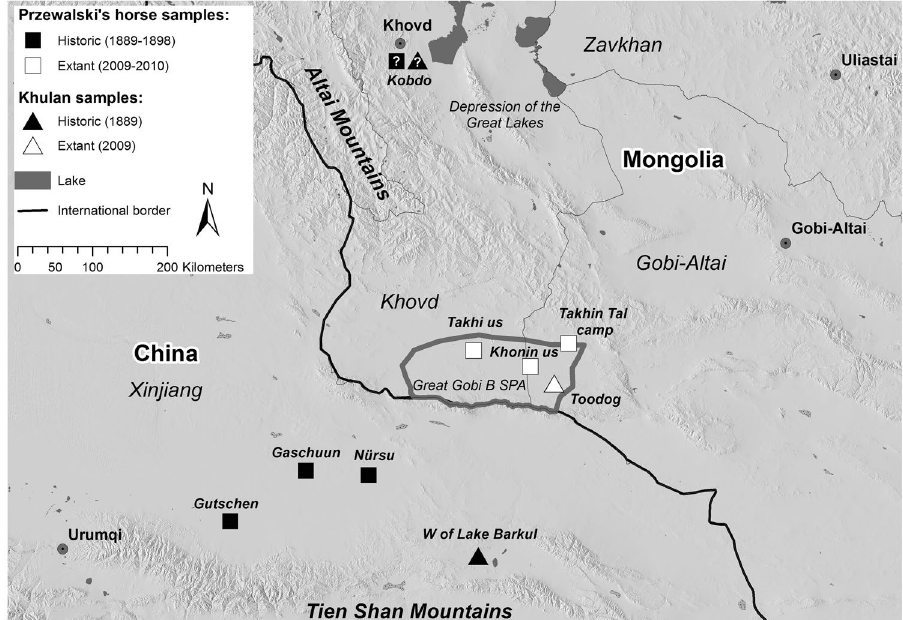
Figure 1. Sampling locations and approximate extent of the Przewalski’s horse distribution in the late 19 th and early 20 th century in what is today’s Xinjiang Uyghur Autonomous Region in northwestern China and Khovd and Gobi-Altai provinces in southwestern Mongolia.? = The exact location of the two historic samples from “Khovd province” (Kobdo) are not known and they may originate from the Depression of the Great Lakes or today’s Great Gobi B SPA. Figure generated in ArcGIS 10.1 (ESRI, Redland, CA, USA, http://www.esri.com/).